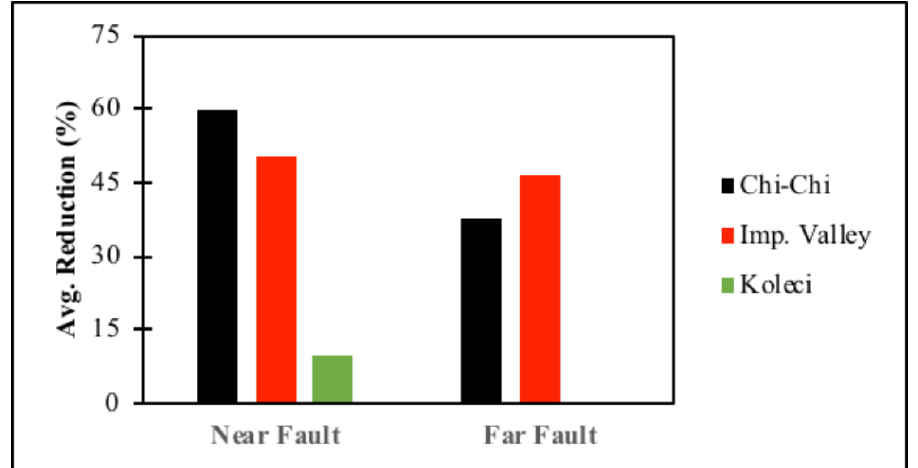
Figure 13. Average storey drifts response reduction of MRE BIS compared to passively IS.